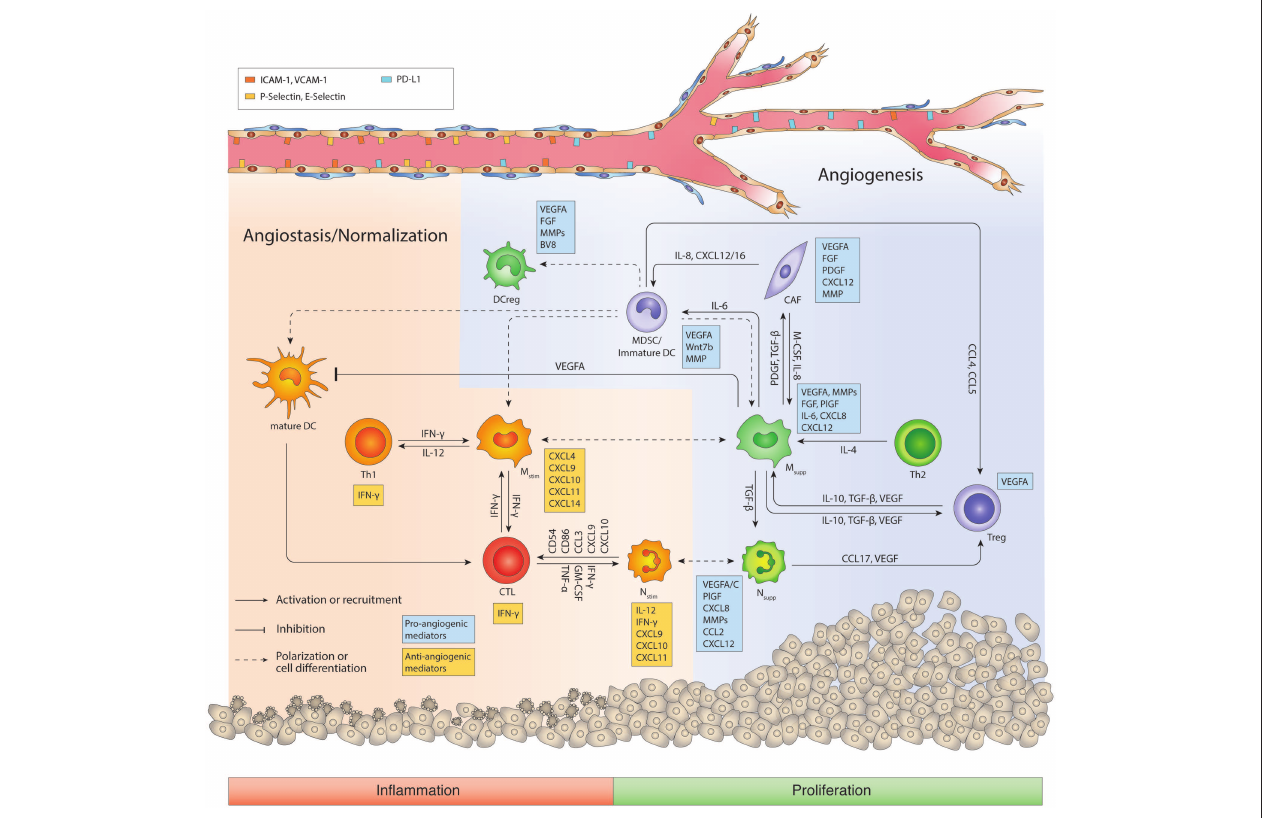
FIGURE 2 | Regulatory network of the tumor immune microenvironment. The tumor microenvironment facilitates cross-talks between immunosuppressive macrophages, MDSCs, N supp , Tregs and CD4 + Th2 cells that promotes angiogenesis, immunosuppression, and tumor progression. During the course of antiangiogenic and/or immunotherapy, myeloid cells including macrophages can switch to an inflammatory phenotype, and cooperate with CD8 + CTLs and CD4 + Th1 cells to generate an anti-tumor response and promote vessel pruning and normalization. Ang2, angiopoietin 2; CAF, Cancer-associated fibroblast; CTL, cytotoxic T lymphocyte; DC, dendritic cell; DCreg, regulatory DC; FGF, Fibroblast growth factor; IFN, interferon; IL, interleukin; M-CSF, Macrophage colony-stimulating factor; MDSC, myeloid-derived suppressor cells; MMP, Matrix metalloproteinases; M stim , immunostimulatory macrophage (M1-like); M supp , immunosuppressive macrophage (M2-like); N stim , immunostimulatory neutrophil (N1-like); N supp , immunosuppressive neutrophil (TAN); PDGF, Platelet-derived growth factor; PlGF, Placental growth factor; TAN, Tumor-associated neutrophil; TGF- β , Transforming growth factor beta; Th, T helper cell; Treg, regulatory T cell; VEGFA, Vascular endothelial growth factor A. Cells in orange or red color represent immunostimulation/type 1 immunity/anti-angiogenic status, while cells in green/blue represent immunosuppression/type 2 immunity/pro-angiogenic